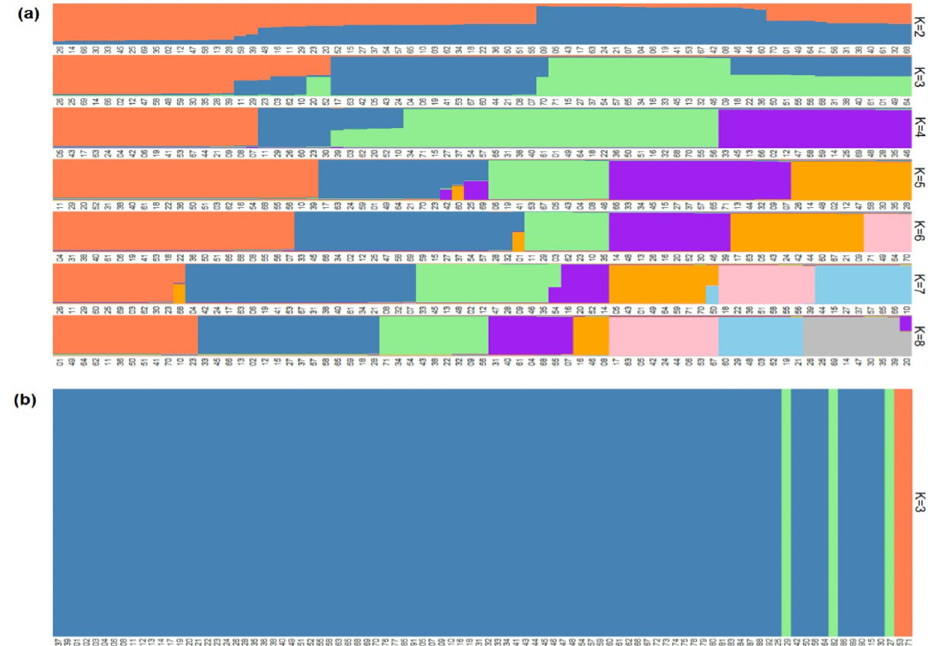
Figure 2. Ancestry plots of sampled individuals. Population structure plots were developed by fastStructure and R package pophelper in giant sequoia ( a ) and coast redwood ( b ).